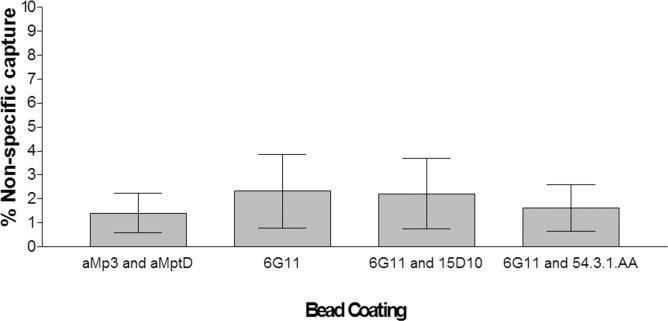
Percentage non-specific capture of a range of Mycobacterium spp. (detailed in Materials and Methods) by variously coated Dynabeads.Figure depicts mean percentage capture ± standard error of results for ten different Mycobacterium spp. captured by each bead or bead combination: MAb 6G11 coated beads; beads coated individually with MAb 6G11 and MAb 15D10 and used as 50:50 mix; beads dually coated with MAb 6G11 and MAb 54.3.1.AA; beads coated individually with biotinylated aMp3 and aMptD peptides and used as 50:50 mix (control).